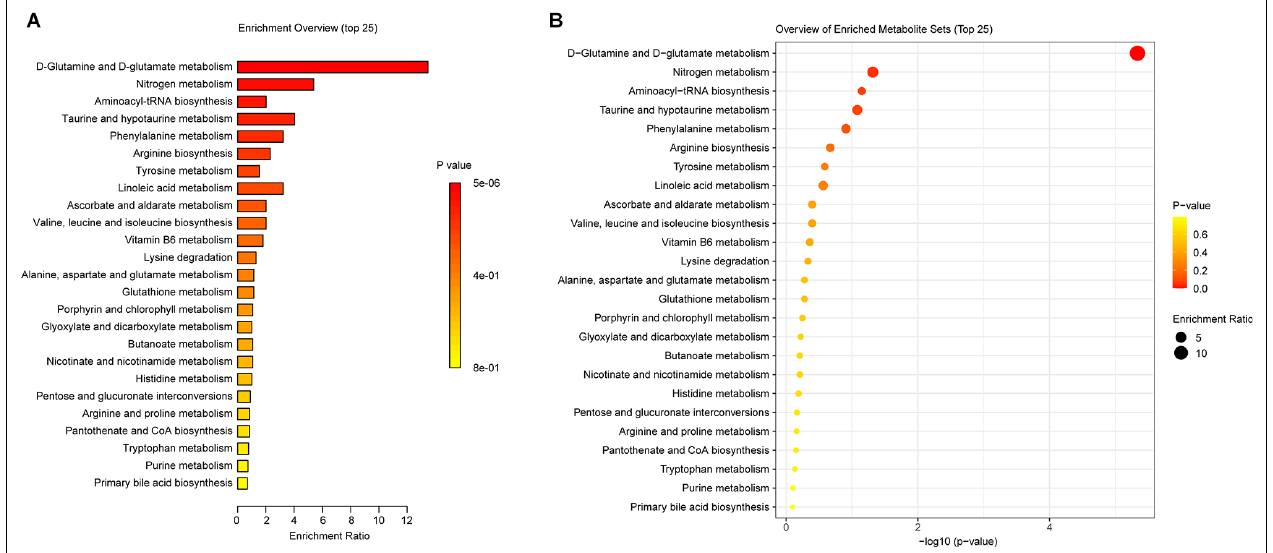
FIGURE 6 | KEGG was used to analyze the gut metabolic function in mice. (A) The enrichment ratio of KEGG pathways. (B) Bubble diagram showed the p -value of these enrichments.